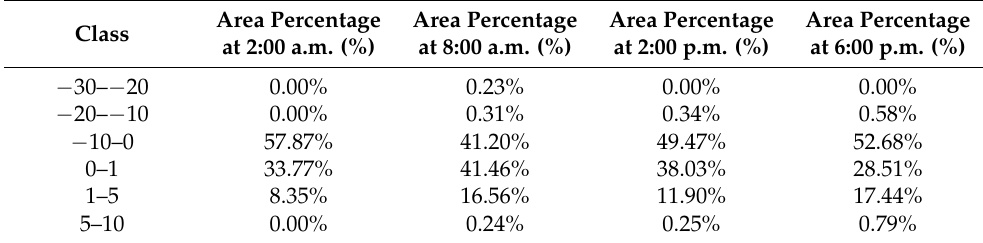
Table 2. Difference of the area percentage of accessibility between the two methods (Wuhan, China,